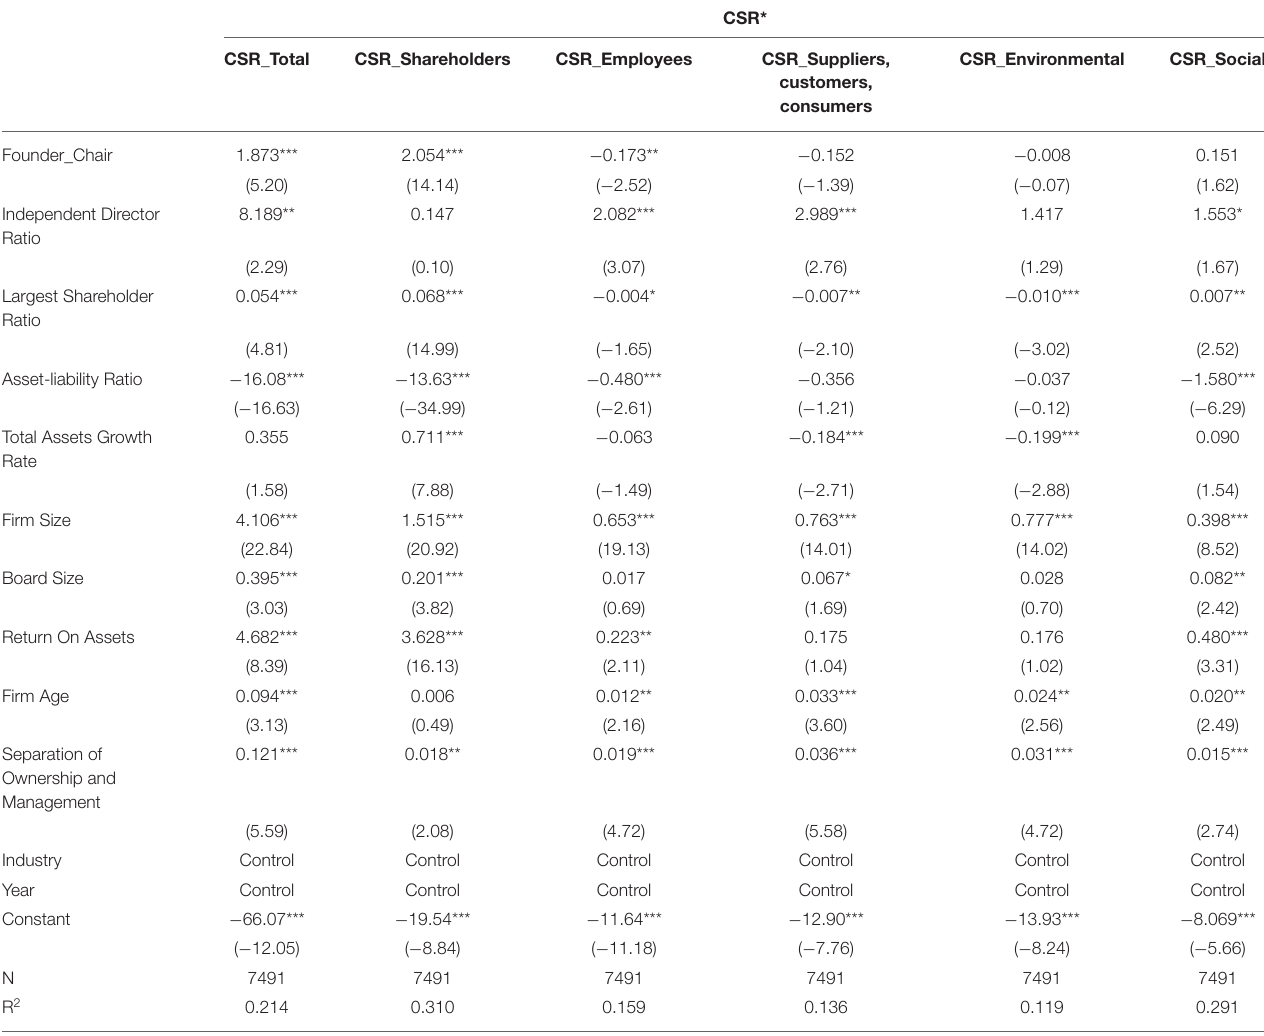
TABLE 9 | Regression results (Founder and Chairman with CSR).